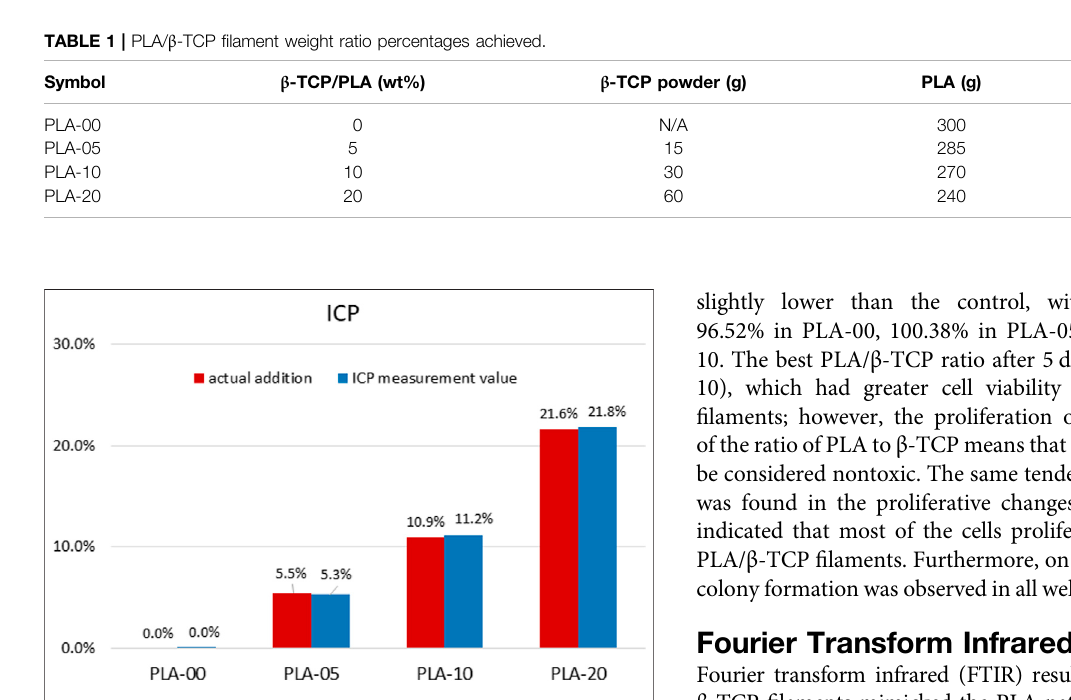
FIGURE 2 | ICP of the β -TCP weight percentage ratio.